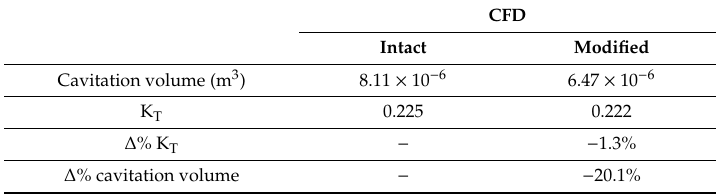
Table 6. K T and cavity volume comparison between Intact and Modified Propeller